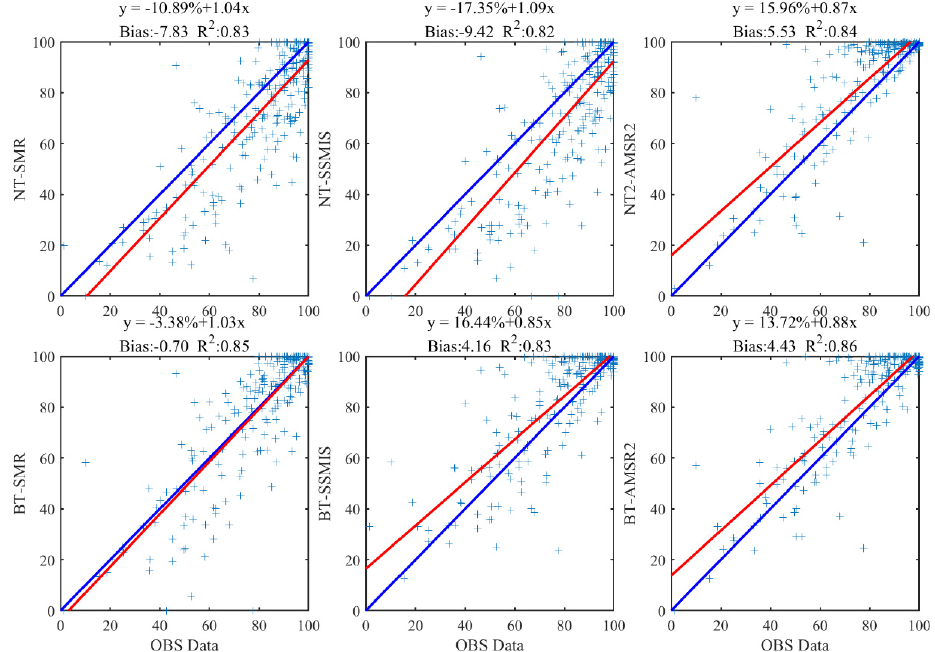
Figure 12. Scatterplots of co-located daily average SIC from visual ship-based observations (Ice Watch/ASSIST, x-axis) and the six satellite SIC algorithm products (y-axes) for the Arctic during 2019–2021. The blue solid lines denote the identity line. The red solid lines denote the linear regression of the respective value pairs. The linear regression equation, bias, and squared linear correlation coefficient (R 2 ) are given at the top of every image. Table 6. Summary of statistics of the comparison between daily average ship-based and PM SIC data for the entire year, only winter, and only